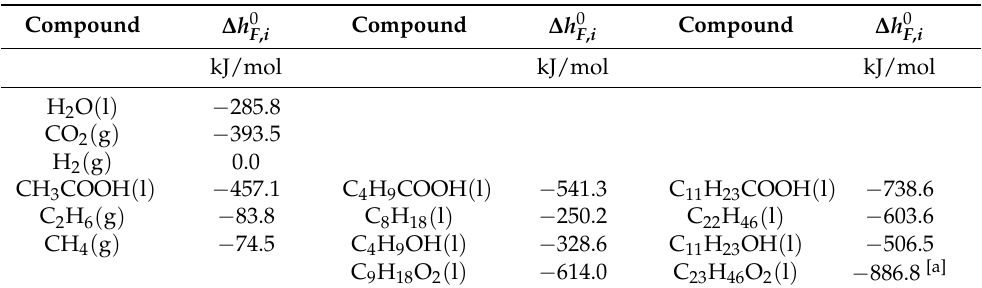
Table A1. Standard enthalpies of formation ∆ h 0 values were retrieved from Aspen Plus database.